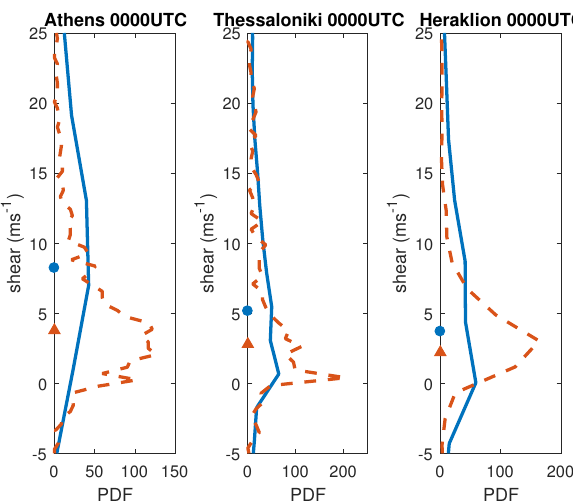
Figure 11. Probability Density Function (PDF) of the wind shear for the SBL (solid lines) and the NBL (dashed lines) types estimated from the 0000UTC soundings over Athens (left panel), Thessaloniki (middle panel) and Heraklion (right panel) with the PBLH estimated using the gradient method. The median values for the corresponding distributions for the SBL (circles) and NBL (triangles) types are also